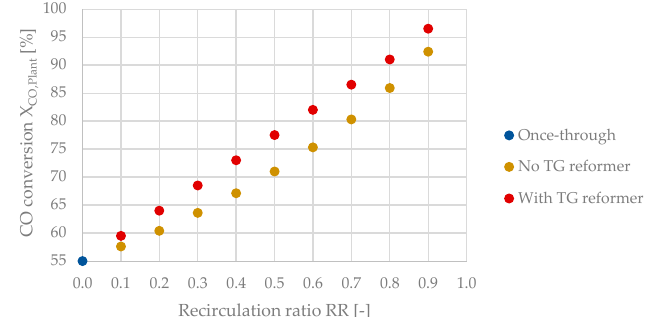
Figure 15. CO conversion at a system level as a function of the recirculation ratio.